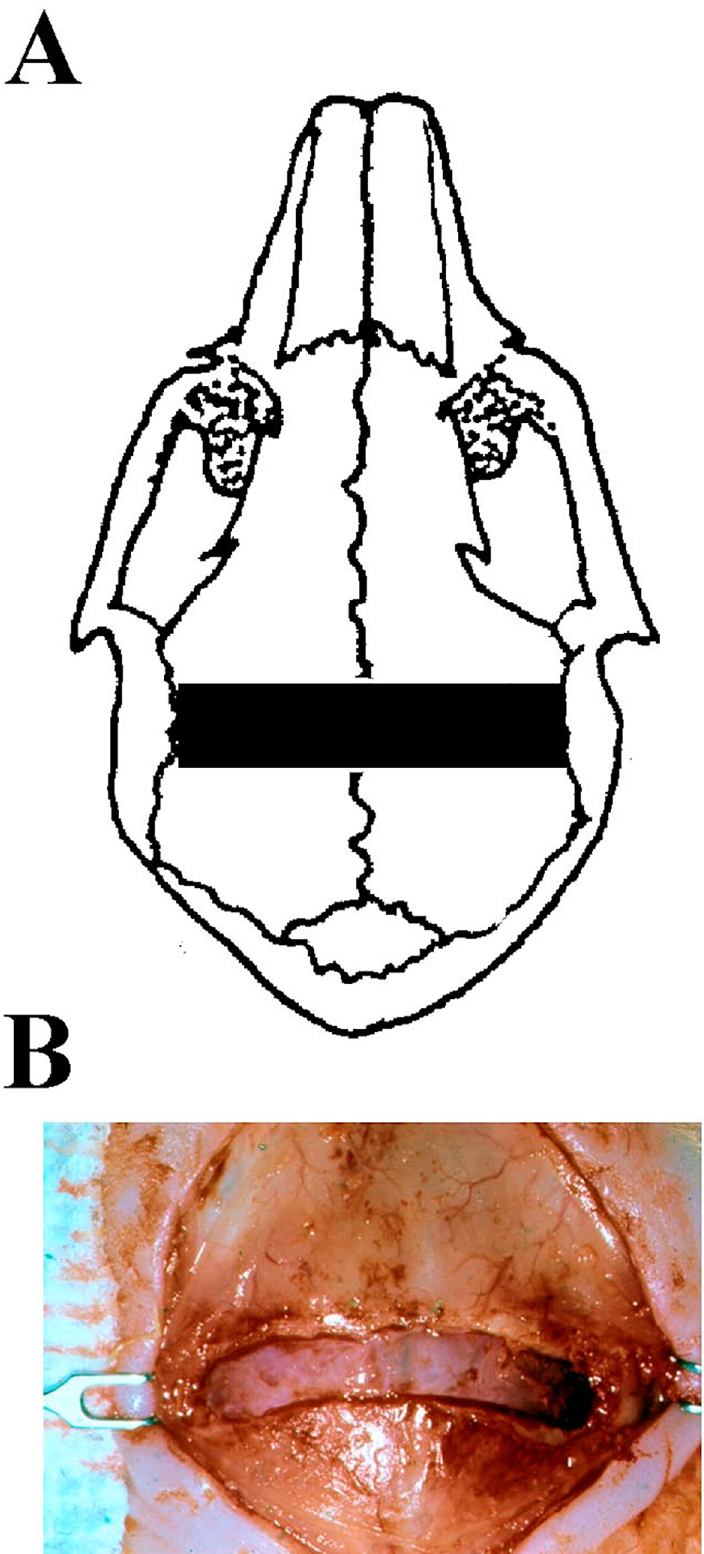
Fig 2. Cartoon (Panel A) and photograph (Panel B) of a rabbit skull after coronal